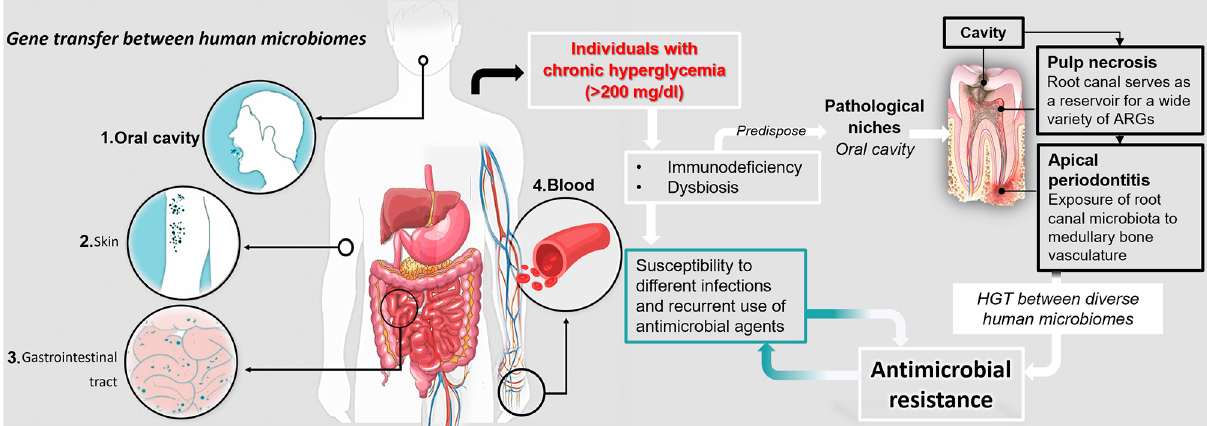
Figure 1- Influence of pathogenic root canal biofilms in individuals with poorly controlled type 2 diabetes mellitus on human antimicrobial resistance. ARGs: antimicrobial resistance genes; HGT: horizontal gene